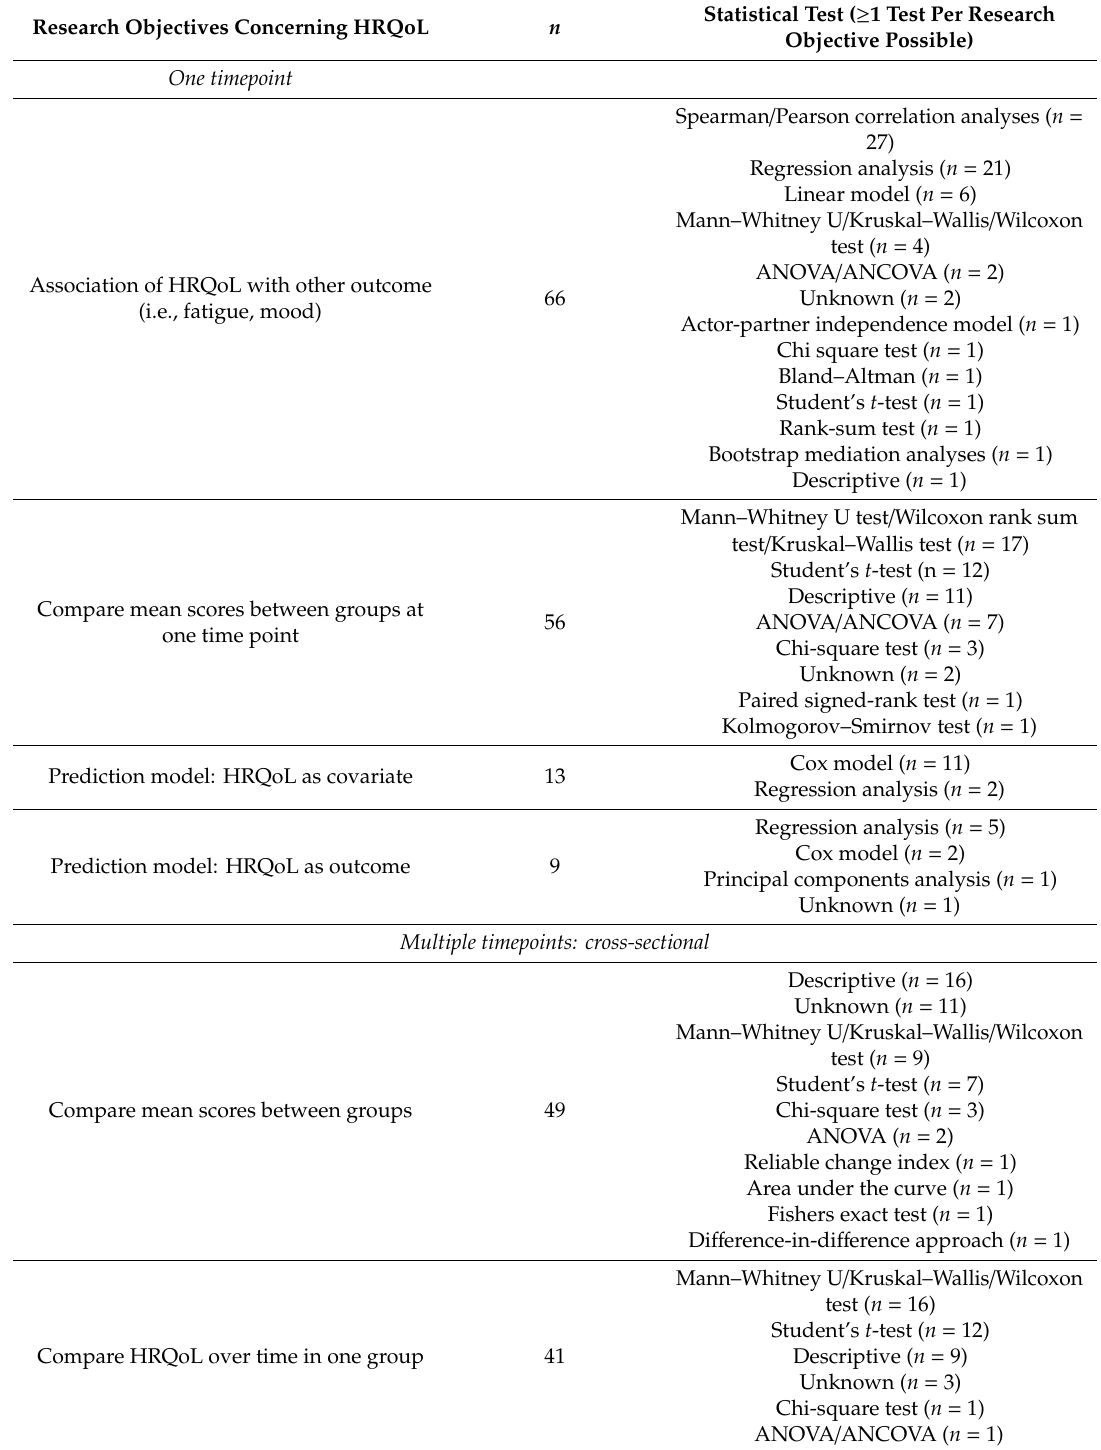
Table 2. Statistical tests per HRQoL research